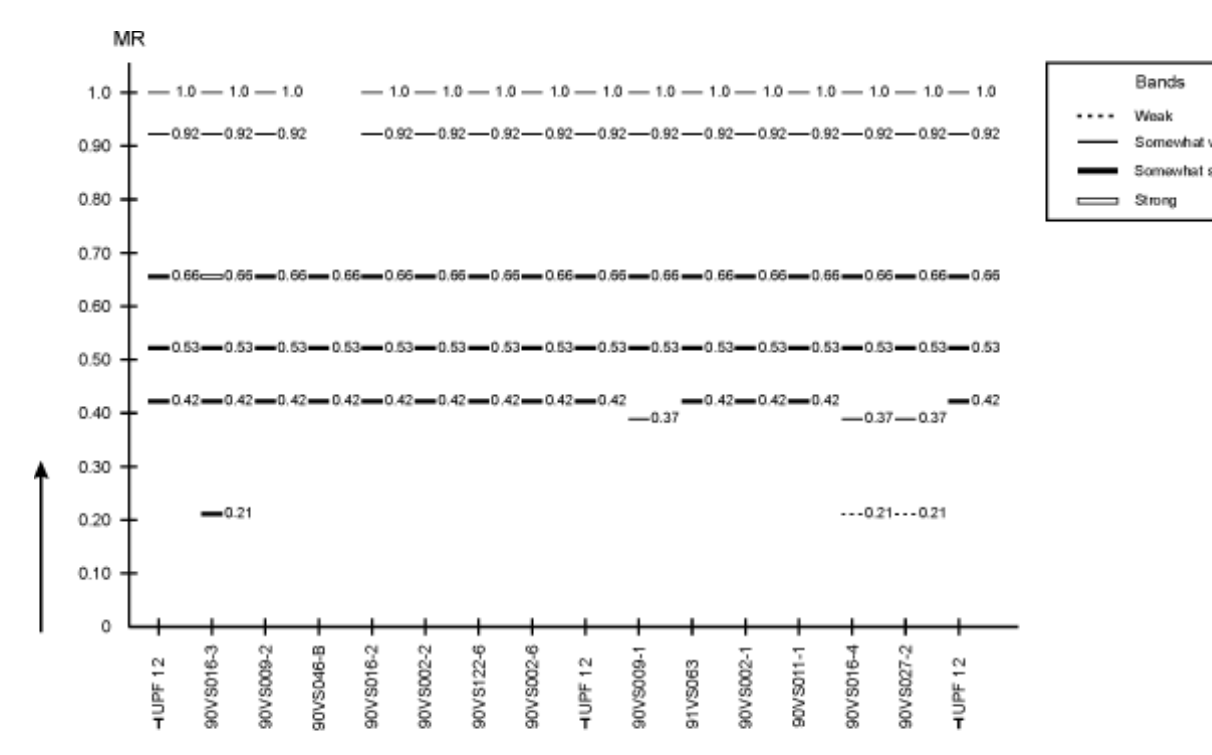
Figure 8 - Schematic representation of electrophoretic patterns for MDH system in oat somaclones derived from cultivar UPF